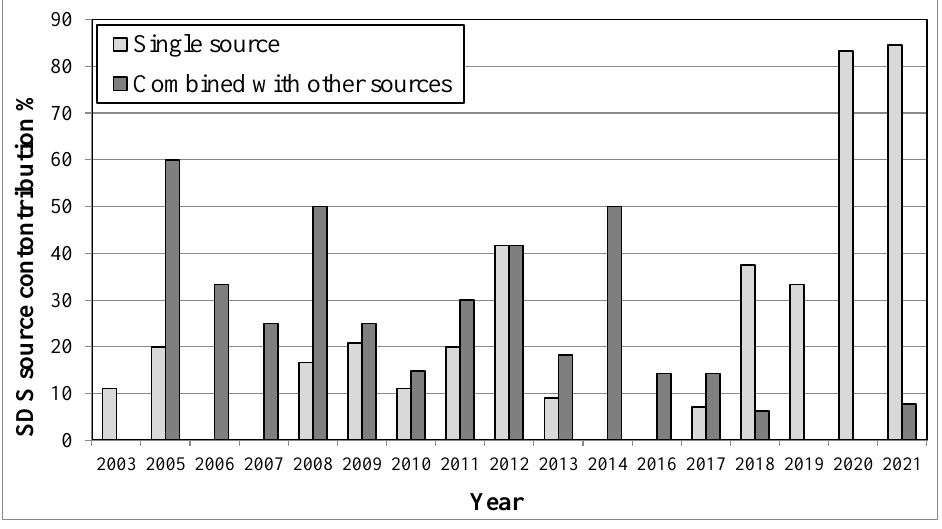
Figure 9. The two SDS hotspots’ contribution percentages in the Middle East as a single source or combined with other sources (2003–2021).